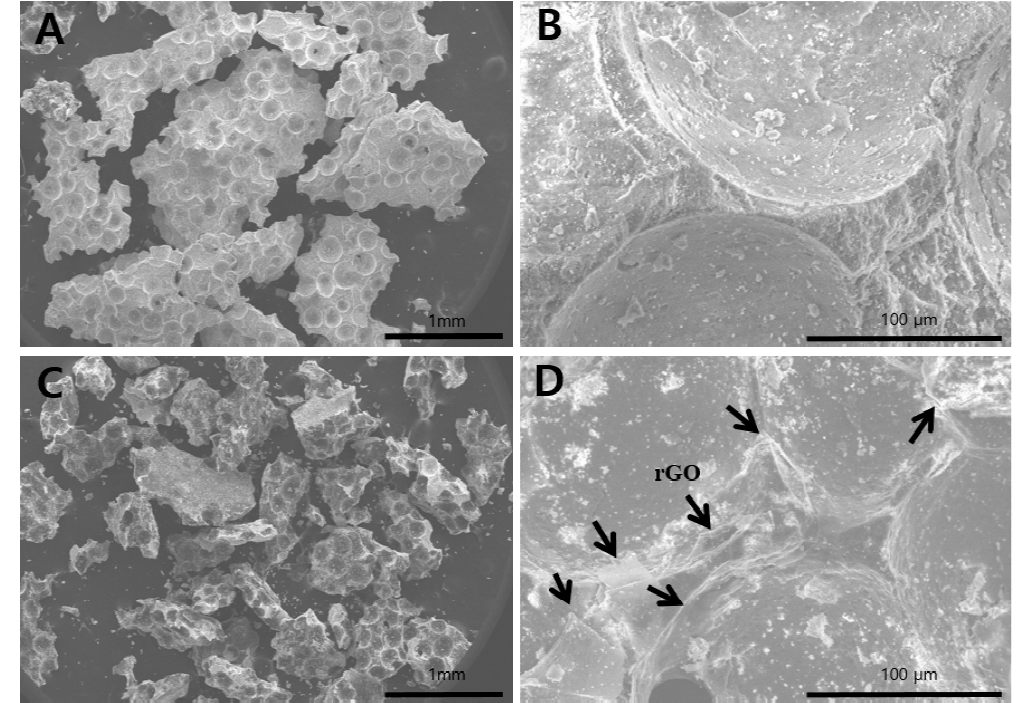
Figure 1. Field emission scanning electron microscope (FE-SEM) images of biphasic calcium phosphate (BCP) microparticles (magnification: 30× ( A ); 500× ( B )) and reduced graphene oxide (rGO)-coated BCP bone graft materials (magnification: 30× ( C ); 500× ( D )). Arrows indicate the rGO nanoplatelets.